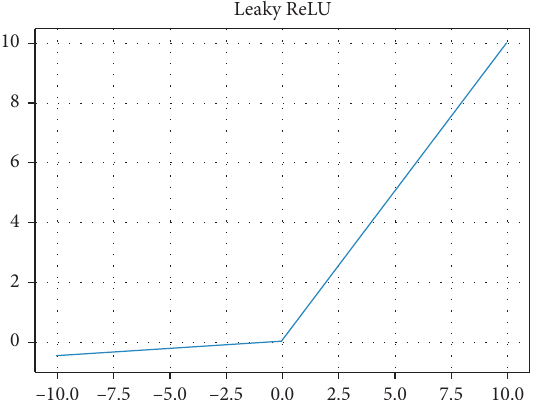
Figure 3: Leaky ReLU activation function.